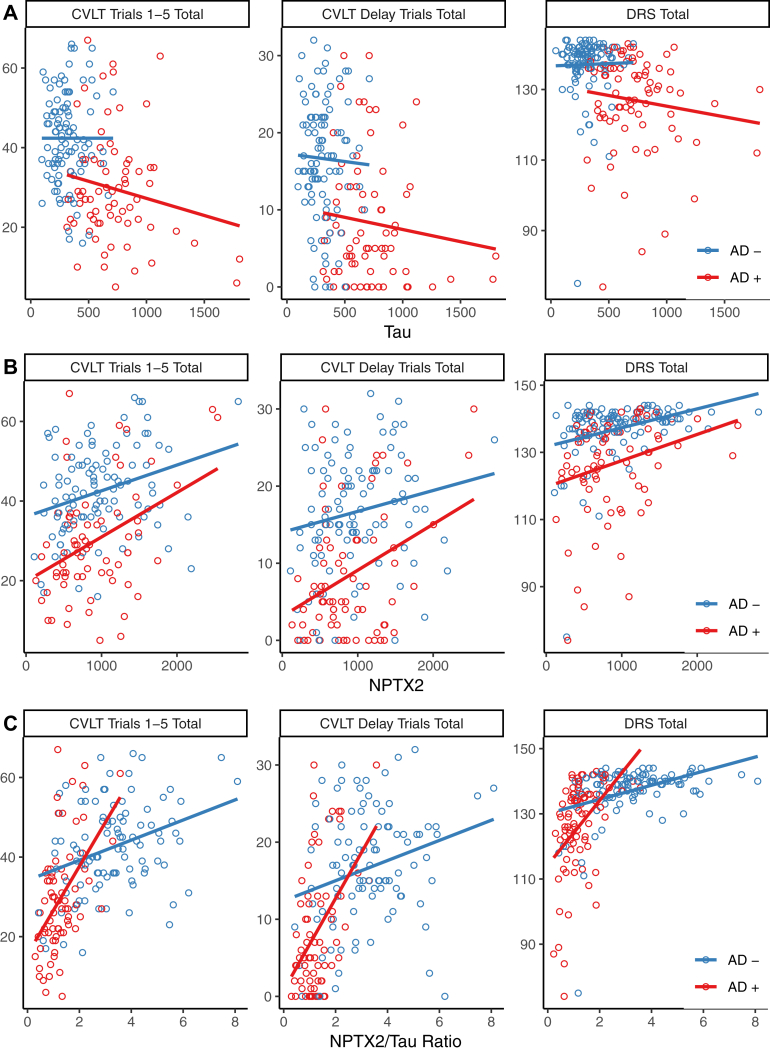
Biomarker prediction of cognitive measures. Correlations of Tau (A), NPTX2 (B), NPTX2/Tau ratio (C), SNAP24/Tau ratio (D), and neurogranin/Tau ratio (E) with cognition assessed with the California Verbal Learning Test (CVLT) immediate recall sum of trials 1–5, the CVLT sum of short and long delay free recall, and the Dementia Rating Scale (MDRS). Participants were dichotomized into “AD-like” (red) or not (blue) based on their CSF Aβ1-42/Tau ratio using the ROC derived cutoff. Linear regression lines for the two groups are plotted in the same colors. The models and effects of biomarkers and other predictors are fully presented in Supplementary Table 2.